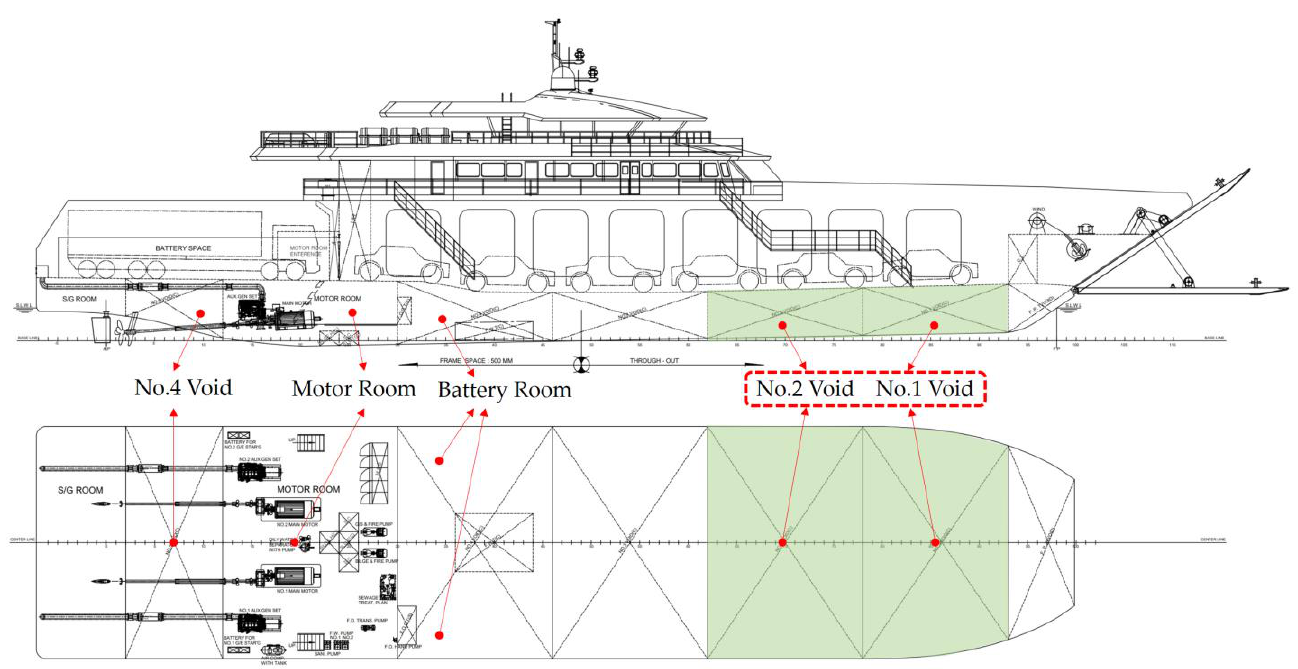
Figure 6. Compartment layout of target vessel. Table 4. Examples of flooding accident cases where the target ship may sink.